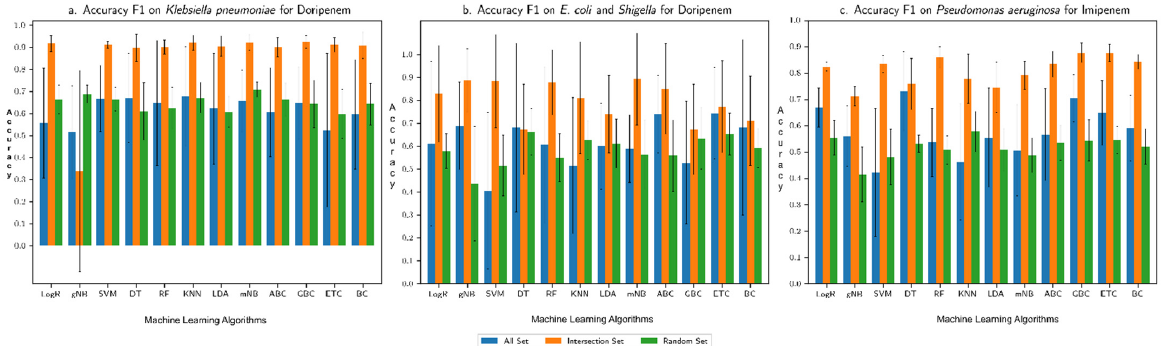
Figure 2. Overall accuracy (F1 score) produced by different machine learning algorithms in predicting resistance to ( a ) Doripenem for K. pneumoniae , ( b ) Doripenem for E. coli and Shigella , and ( c ) Imipenem for P. aeruginosa . “All Set” denotes all genes of a genome of interest, “Intersection Set” contains genes that consistently ranked high in their importance in discriminating resistant from susceptible strains in each round of cross-validation, and “Random Set” contains randomly sampled genes from All Set (same number of genes as in Intersection Set). Performance was assessed for each of three input datasets in a 6-fold cross-validation setting.